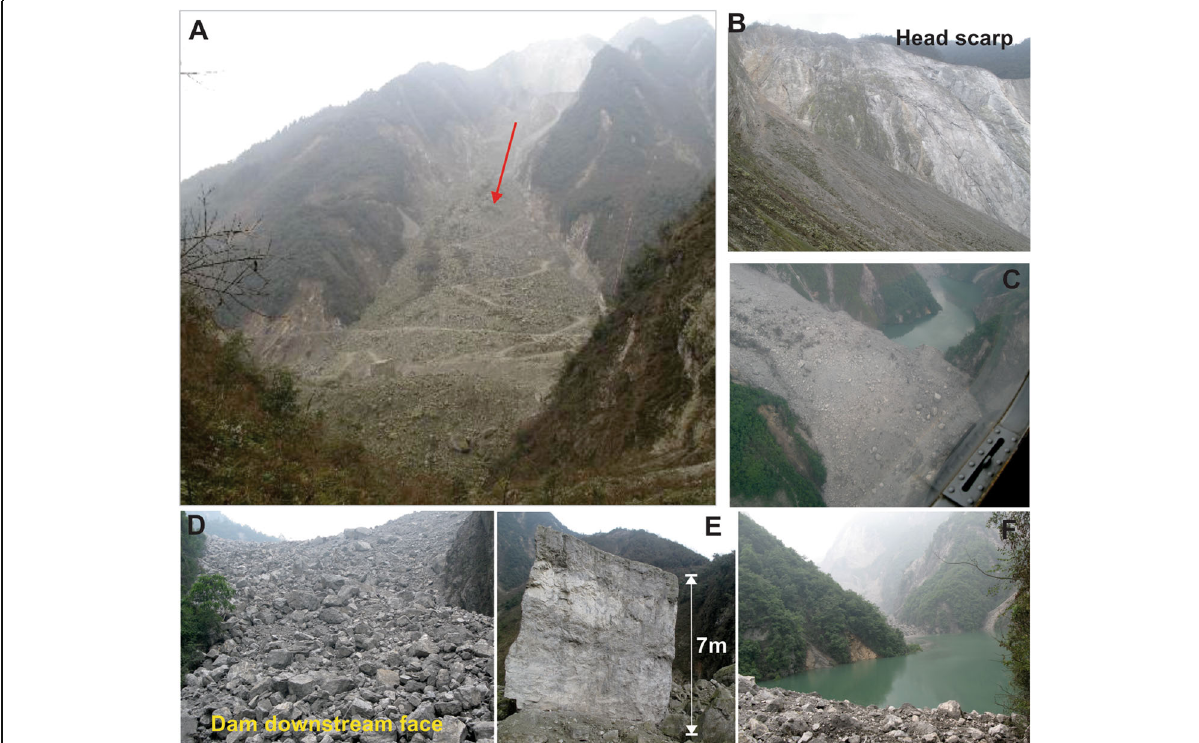
Fig. 5 Laoyingyan landslide. a Overview of the Laoyingyan landslide; b Head scarp; c Helicopter view of the dam body; d Dam downstream face; e : The largest boulder in the deposition zone; and f Barrier